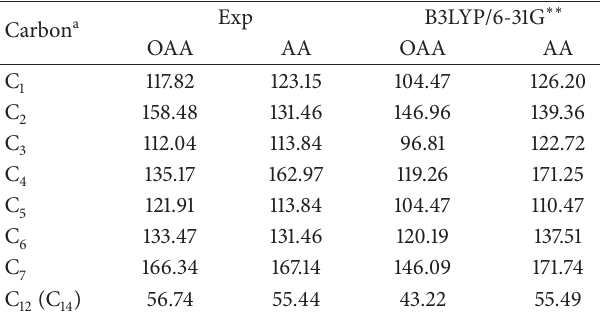
Table 12: Calculated 13 C NMR chemical shifts (ppm) of O-Anisic acid (OAA) and Anisic acid (AA).